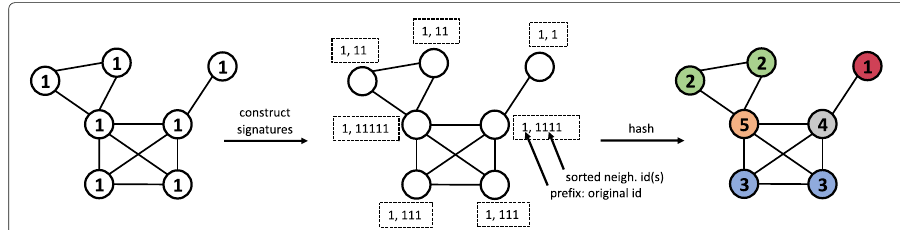
Fig. 3 The Weisfeiler-Lehman (WL) algorithm can be used to generate structure-based labels for unlabeled graphs. We initially assign the same id/label to each node in the graph. Each iteration of the algorithm is comprised of two steps: node signature construction and hashing. The illustration above shows one